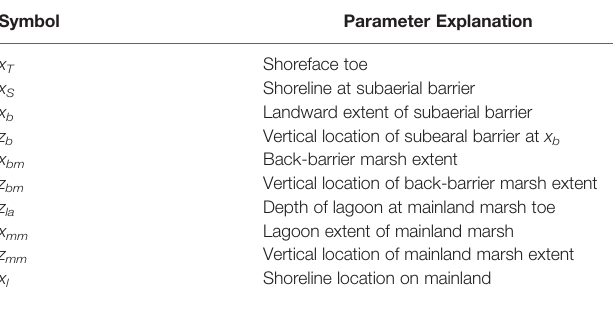
TABLE 2 | Locations of subsystem boundaries simulated in the governing equations provided in Lorenzo-Trueba and Mariotti (2017). Symbol Parameter Explanation